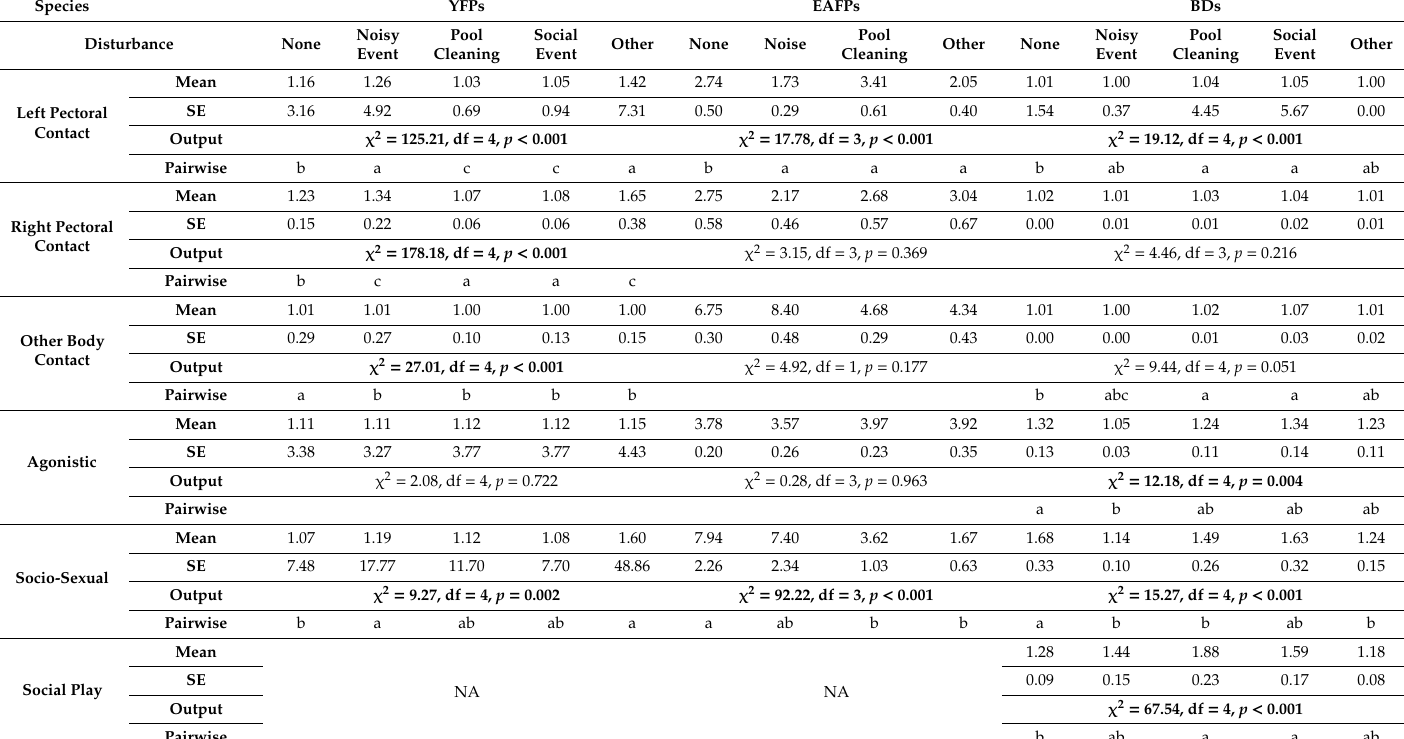
Table 8. Fitted means and standard errors of the frequency of each social behaviour depending on disturbances for Yangtze finless porpoises (YFPs), East-Asian finless porpoises (EAFPs) and bottlenose dolphins (BDs). Outputs come from Wald chi-squared tests run on Generalized linear mixed models, significant outputs are bolded. For each species and each behaviour, items sharing the same letter did not di ff er significantly, items that do not share the same letter di ff er significantly (post-hoc tests with sequential Bonferroni